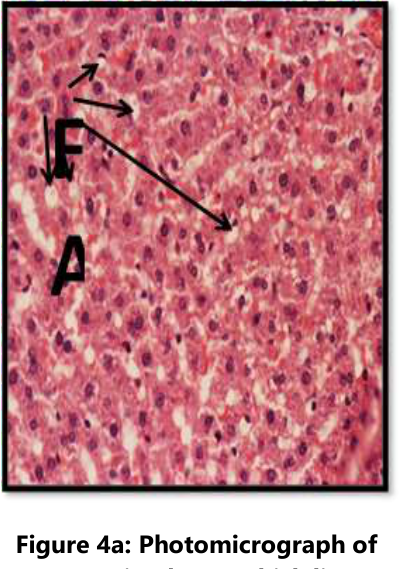
Figure 4a: Photomicrograph of H&E stained 4 µm thick liver section showing fat droplets in rat hepatocytes on a high-fat diet (group 2) at ×400.